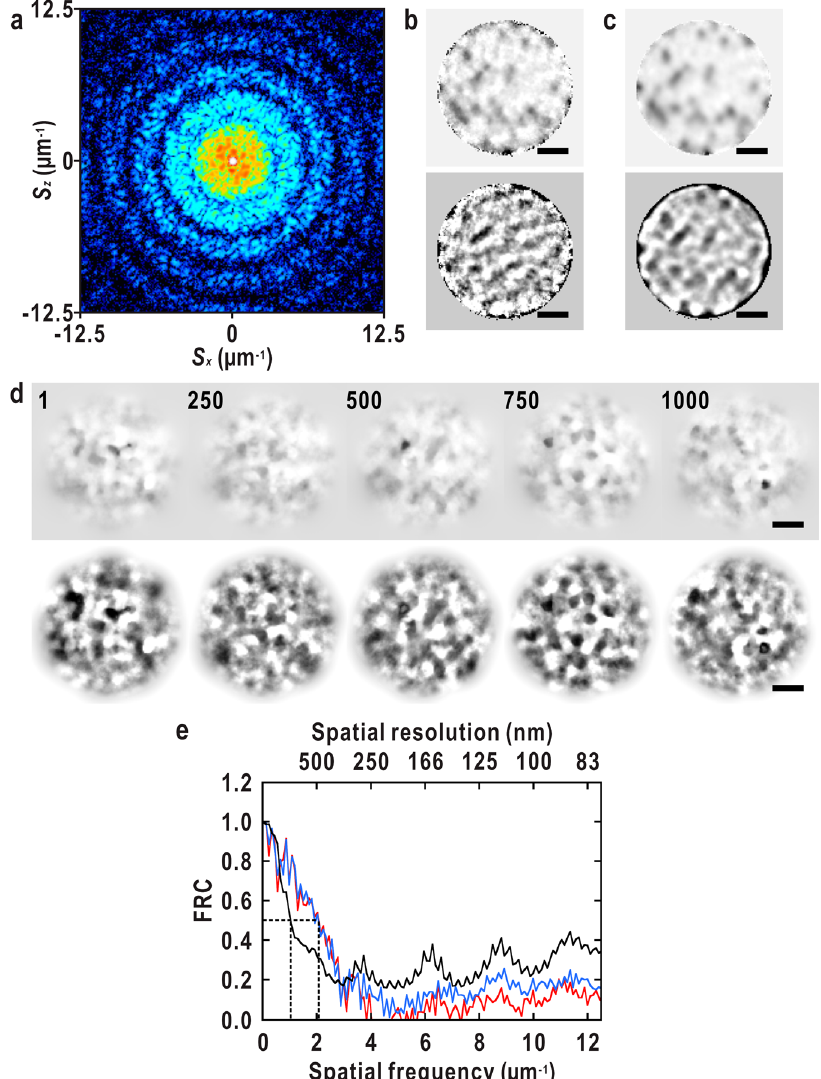
Fig. 8 Comparison of the single- and multiple-shot coherent diffraction imaging using apodised illumination. a Typical simulated diffraction intensity pattern of the Brownian motion model at glycerine concentration of 90%w/v and temperature of 283 K accumulated over the dwell time. The object model at the 500th frame is shown. The intense peak at the centre corresponds to the bright- fi eld region. Phase (upper) and absorption (lower) contrast object frames of b the best and c averaged single-shot reconstructions. d Phase (upper) and absorption (lower) contrast object frames reconstructed using multiple-frame ptychographic iterative engine with total-variation regularisation (mf-PIE-TV). e Fourier ring correlation (FRC) curves for the single (red) and averaged (blue) single-shot reconstructions, and the mf-PIE-TV reconstruction (black). The broken line indicates a 0.5 threshold and corresponding spatial frequency. The colour scale for ( a ) and grayscale for ( b – d ) are the same as that shown in Fig. 4. The frame numbers for the mf-PIE-TV reconstruction are indicated in the phase images. Scale bars indicate 1 μ